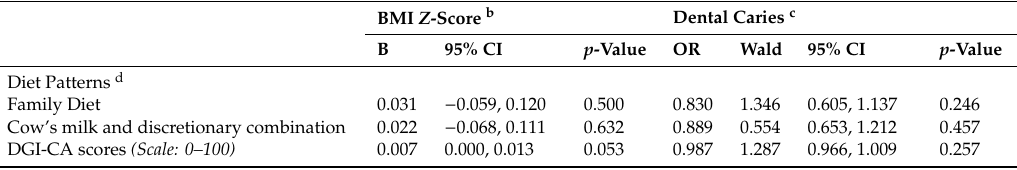
Table 3. Associations between dietary patterns at 12 months and BMI Z -scores, BMI-weight category, dental caries at 24–36 months, after adjusting for covariates a .